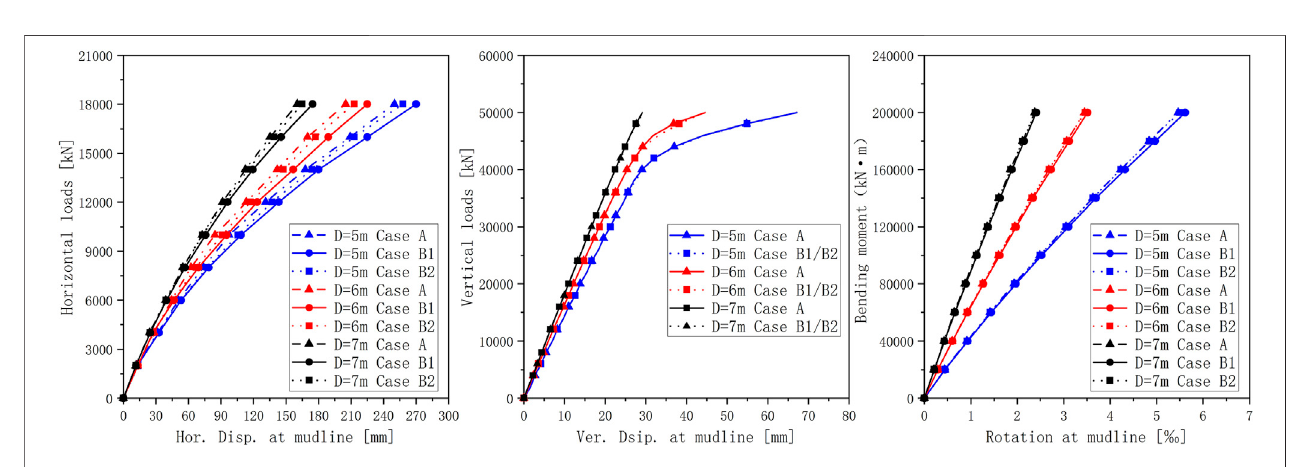
FIGURE 6 | Load – displacement curve at the pile top.